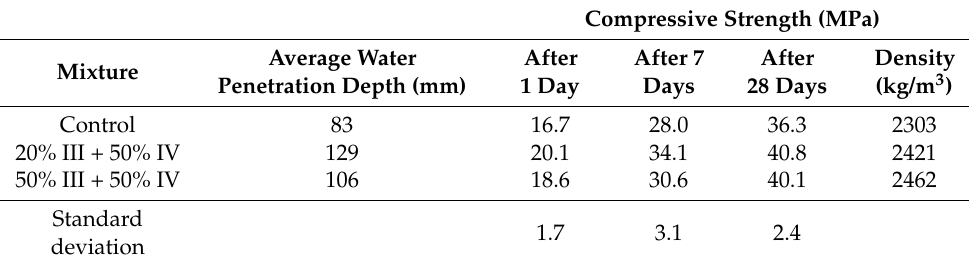
Table 7. Water penetration depth, compressive strength, and density of